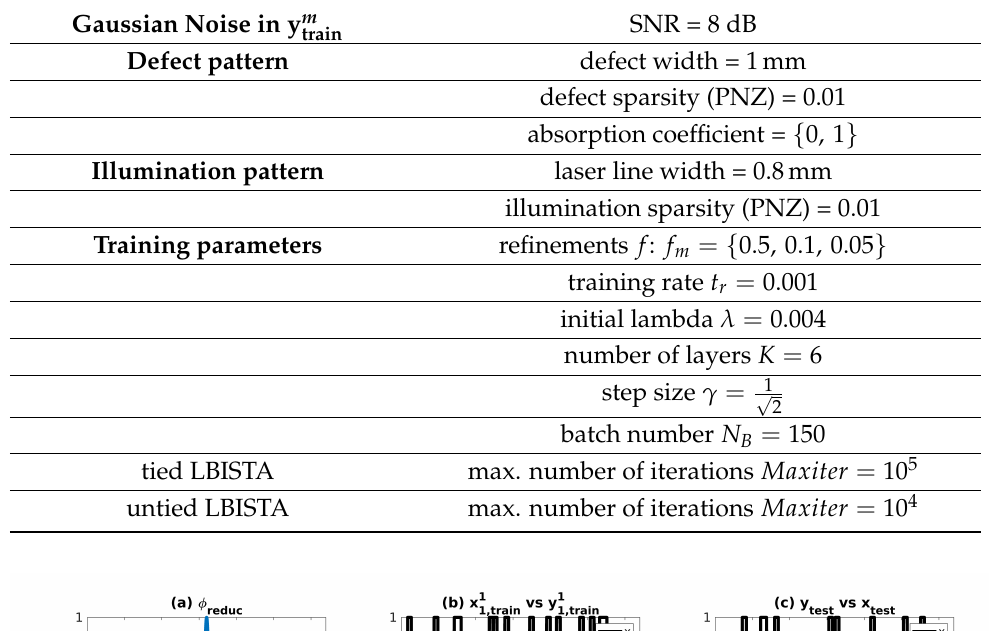
Table 1. Parameters used in LBISTA for problem definition and training.